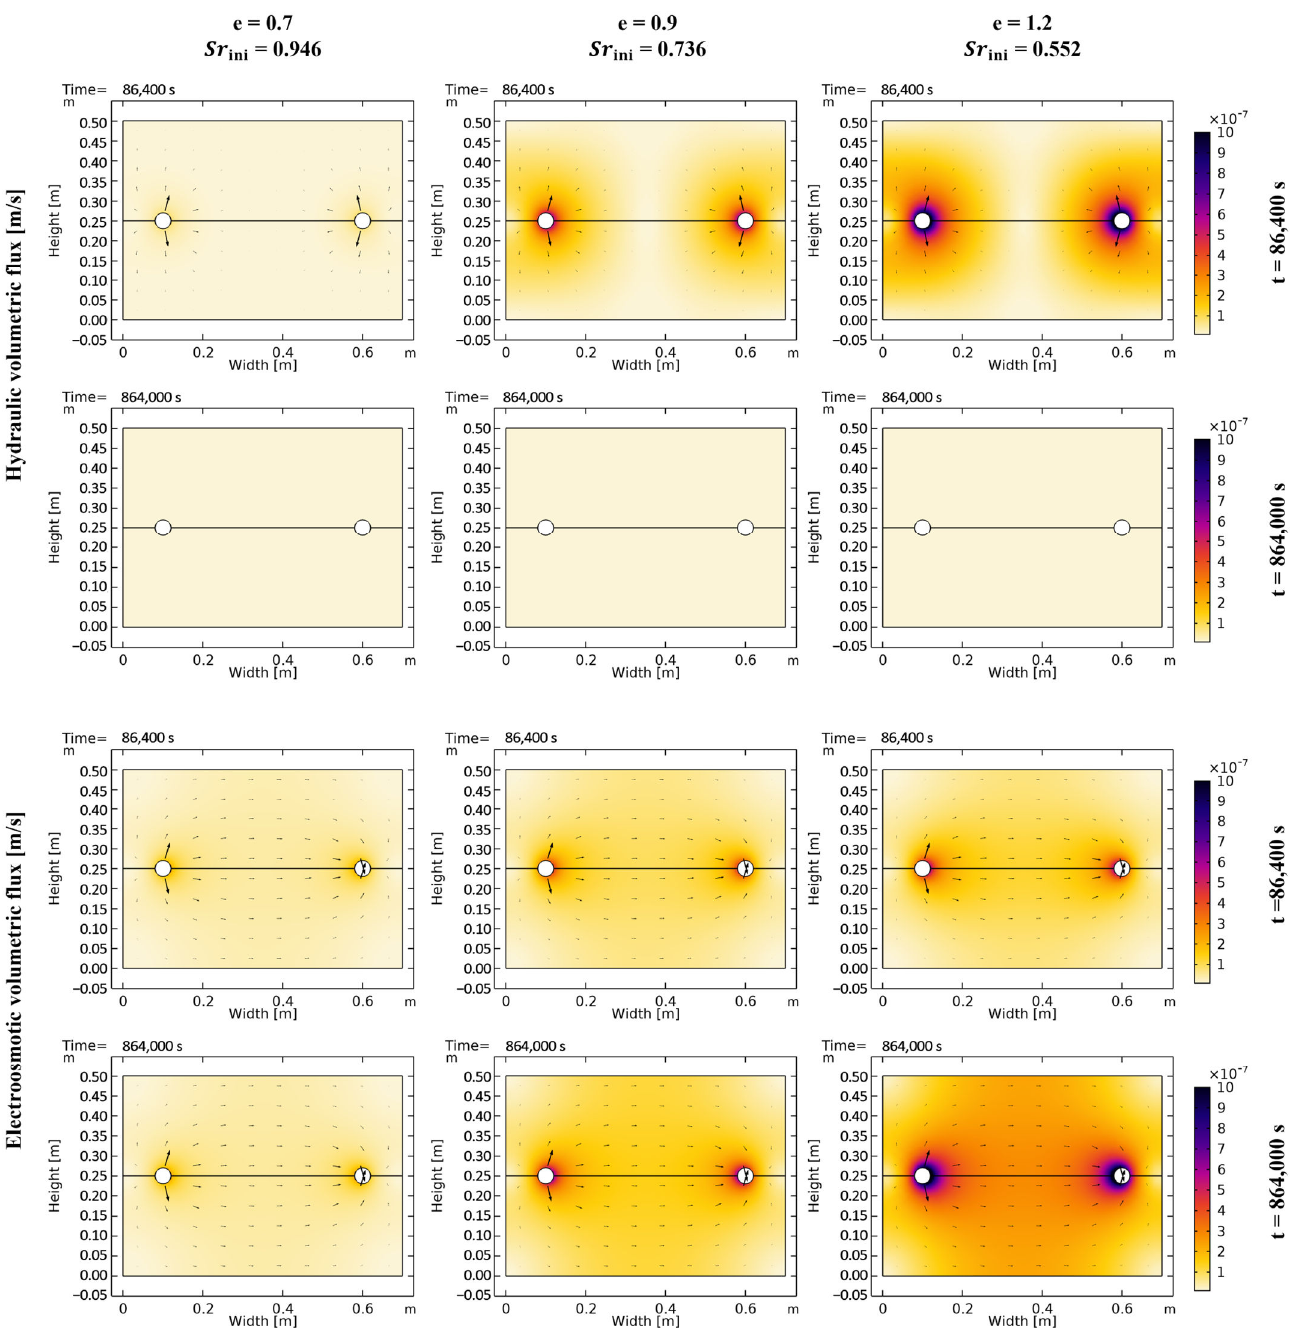
Figure 4. 2D maps of hydraulic and electroosmotic volumetric fluxes evaluated at two times, 86,400 (1 d) and 864,000 s (10 d), and three void ratios, 0.7, 0.9, and 1.2, when the electrodes were in the electrolyte reservoirs, as shown in Figure 1a. Electric potential gradient applied: 1 Vcm −1 .